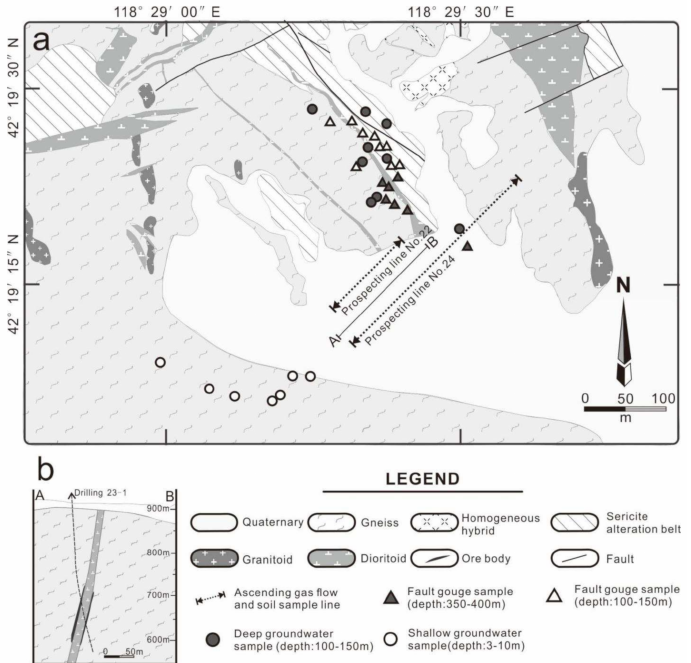
Figure 2. ( a ) Detailed geological map and ( b ) cross-section of the Chaihulanzi gold deposits. (Modi- fied by [57]).